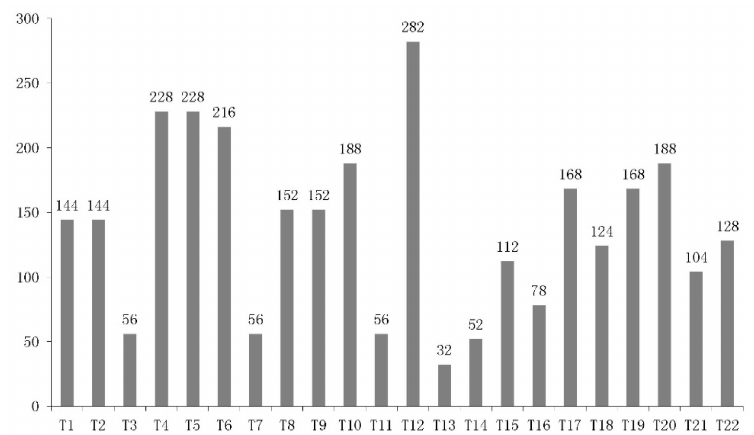
Figure 4. Risk score for each heavy metal mine tailings pond.